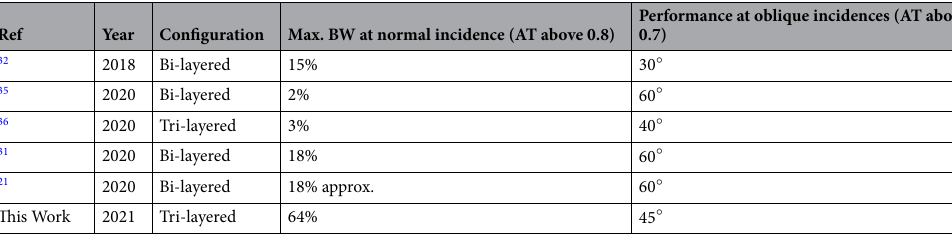
Table 1. Comparison with recently published